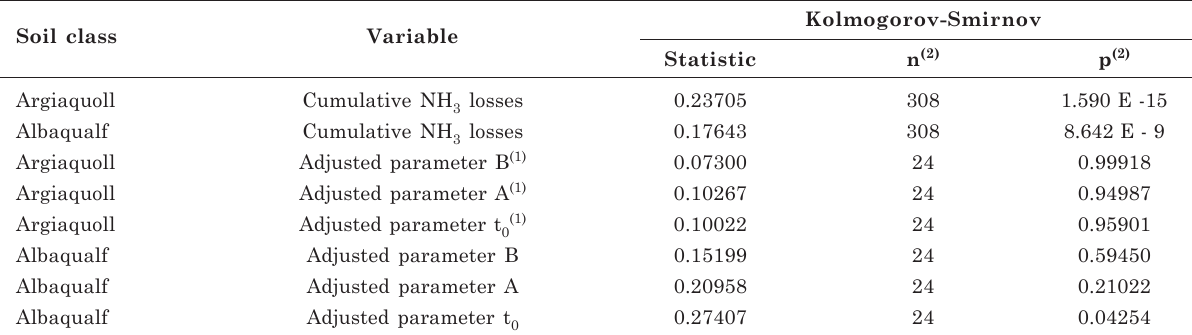
(1) B: maximum culmulative ammonia volatilization loss, A: maximum rate of ammonia volatilization, t function. (2) n: number of observations; p: probability of Kolmogorov-Smirnov